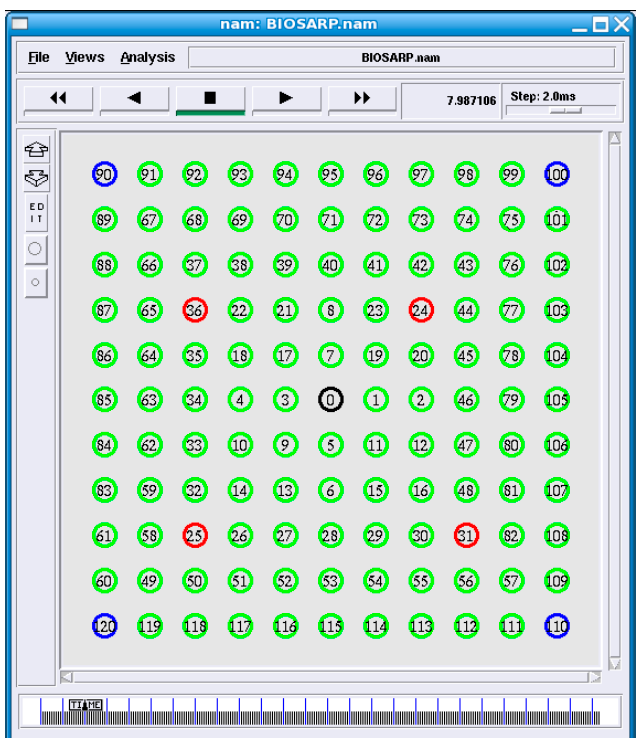
Figure 5. Network simulation grid (source nodes (blue), sensor nodes (green), malicious nodes (red), and sink node (black)).